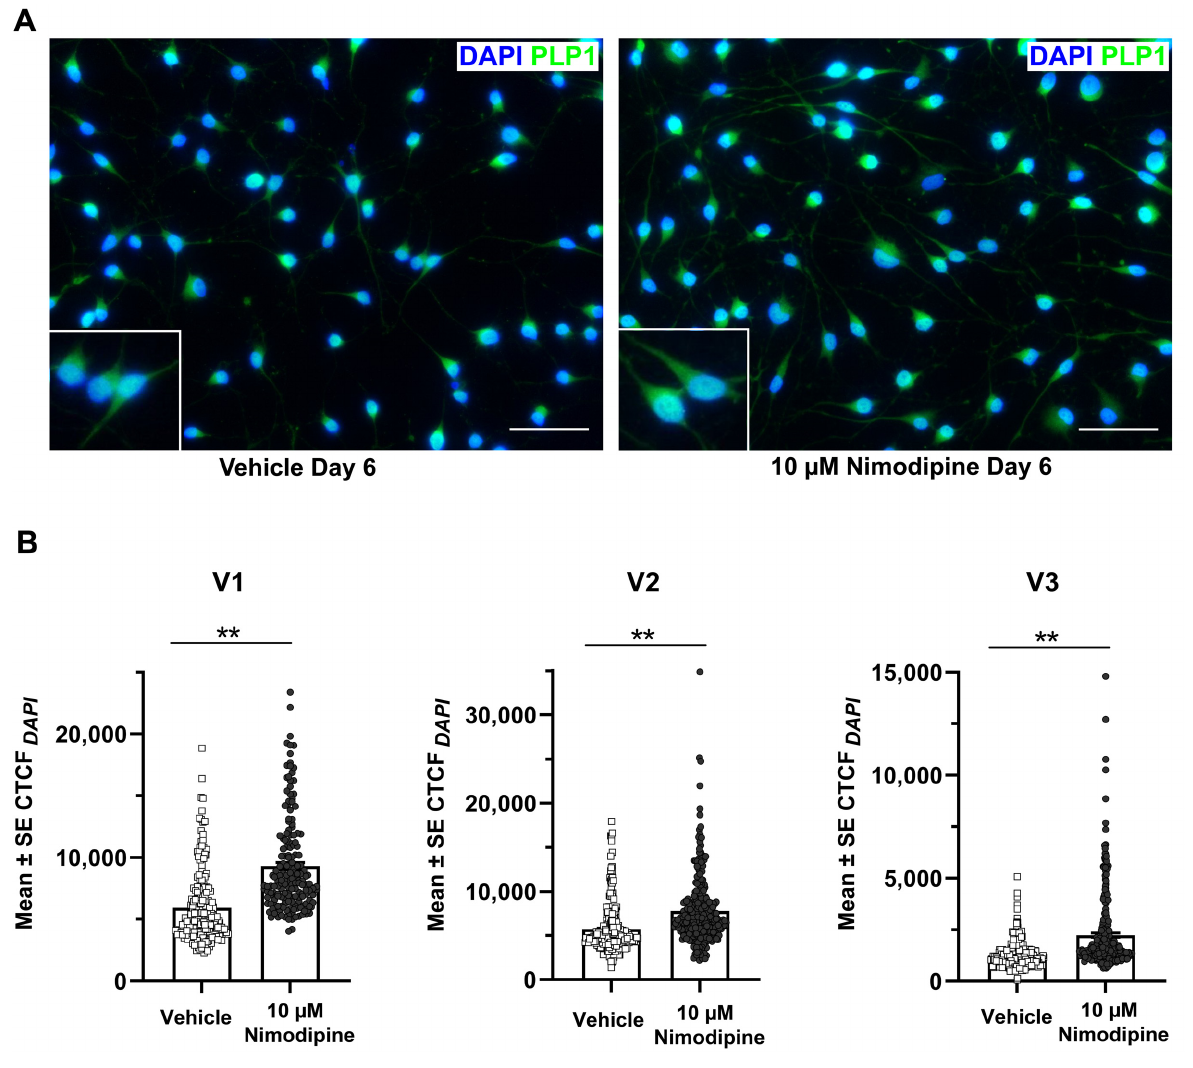
Figure 3. Effects of nimodipine on the PLP1 fluorescence signal. ( A ) Representative immunofluo- rescence images of OLN-93 cells stained for PLP1 and DAPI after incubation in oligodendrocyte differentiation medium and treatment with 10 µ M nimodipine or dimethyl sulfoxide (vehicle) for 6 days. Scale bars represent 50 µ m. ( B ) Quantification of the PLP1 fluorescence signal. The CTCF of PLP1 in relation to the DAPI-positive area (CTCF DAPI ) was quantified in 174–438 cells each